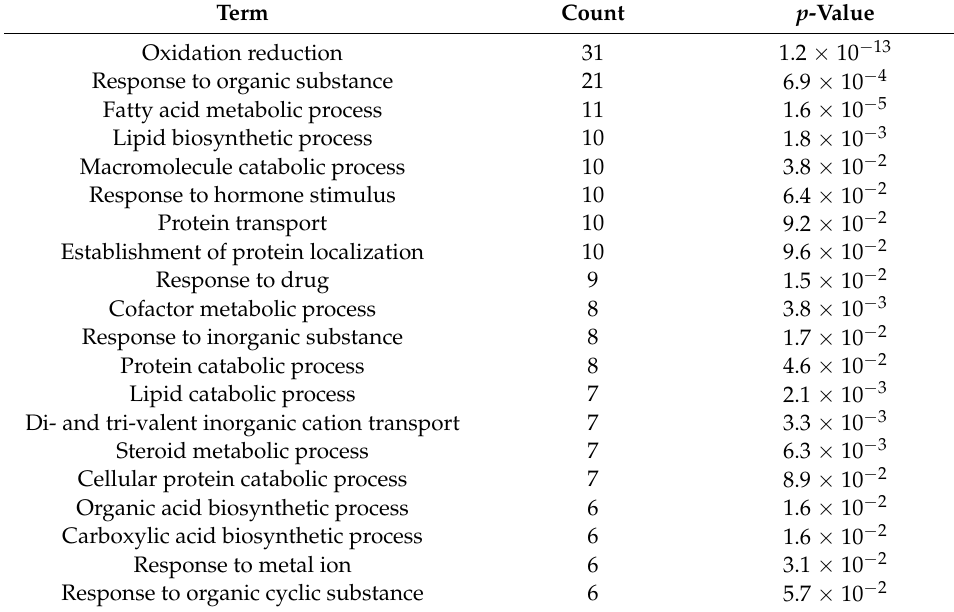
Table 1. The major biological processes by analyzing the differentially expressed proteins. Term